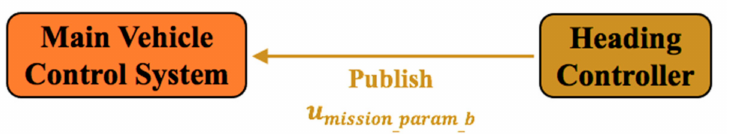
Figure 14. Exchange of data between the main vehicle control system and a heading controller when the glider followed a heading commanded by the backseat driver.